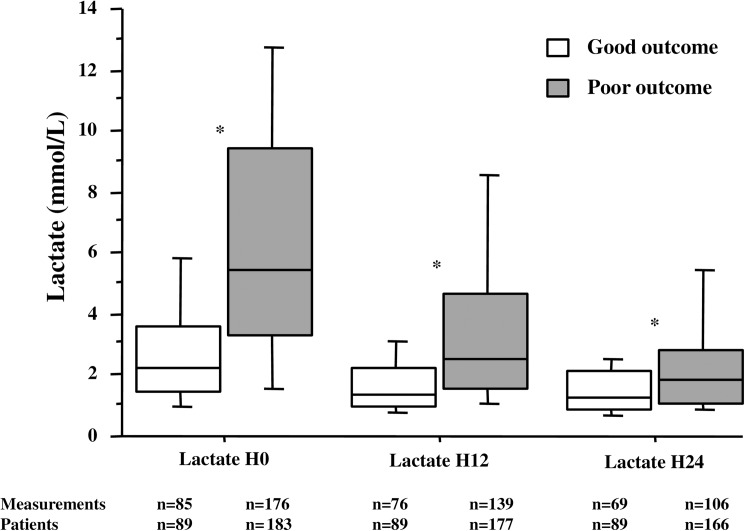
Arterial lactate levels during the 24-hours study period in good and poor outcomes groups.Data expressed as median and interquartile range. Comparisons between groups by Mann-Whitney test: * p<0.01.